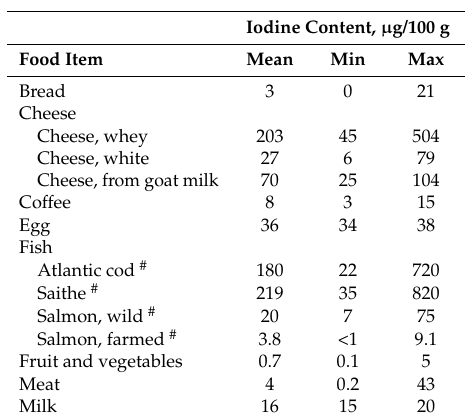
Table 1. Average iodine content in selected food groups, µ g/100